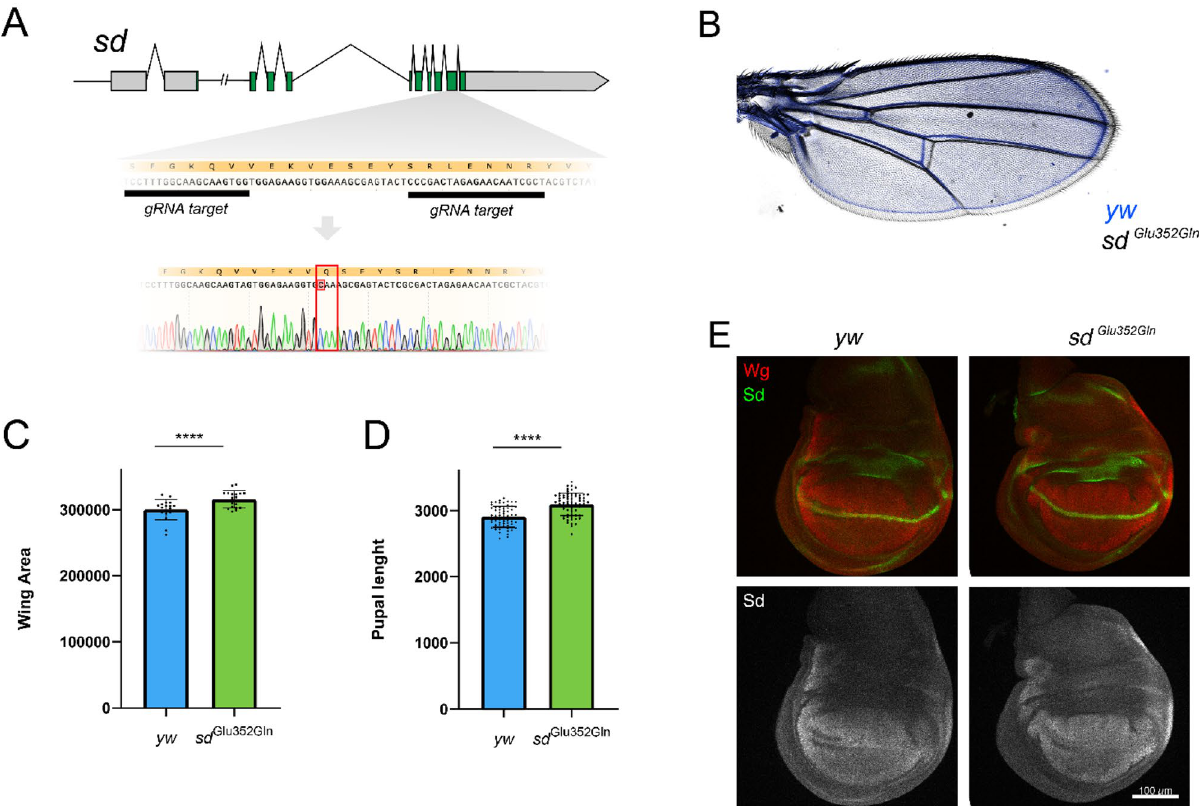
Figure 2. Generation of Glu352Gln Sd flies and in vivo analysis. ( A ) Structure of sd gene in Drosophila . Spacer sequence of gRNAs in highlighted, along with the nucleotide and putative amino acid sequence. Below, Sanger sequencing results of the Glu352Gln Sd mutant. Notice that some silent mutations are introduced in order to avoid donor plasmid cutting by the gRNAs (grey points). ( B ) Superimposed wt Sd (blue) and Glu352Gln Sd mutant (grey) wings. ( C ) Quantification of wing area in arbitrary units, showing a small (5.2%) but significant increase in wing area in Glu352Gln Sd mutants. P value < 0.0001 (wt Sd n = 18, Glu352Gln Sd n = 18). ( D ) Quantification of pupal size (6.8% difference). P value < 0.0001 (wt Sd n = 60, Glu352Gln Sd n = 64). ( E ) Immunostaining of Sd and Wg proteins in third instar imaginal wing discs. The Glu352Gln Sd mutation does not result in a noticeable change of Sd